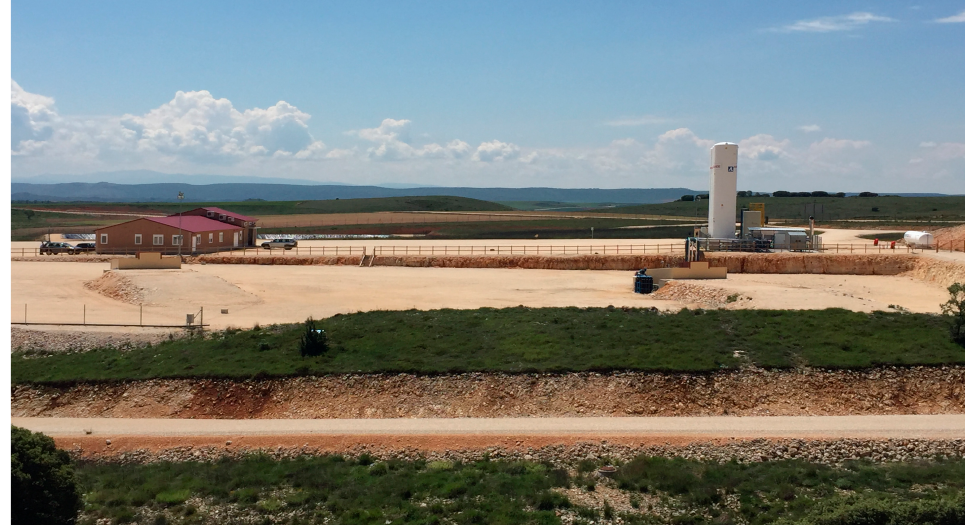
Figure 2. The schemes of the injection well HI ( top ), observation well HA ( middle ) and panoramic view ( bottom ) of the pilot (adapted from de Dios et al. 2017 [11]).